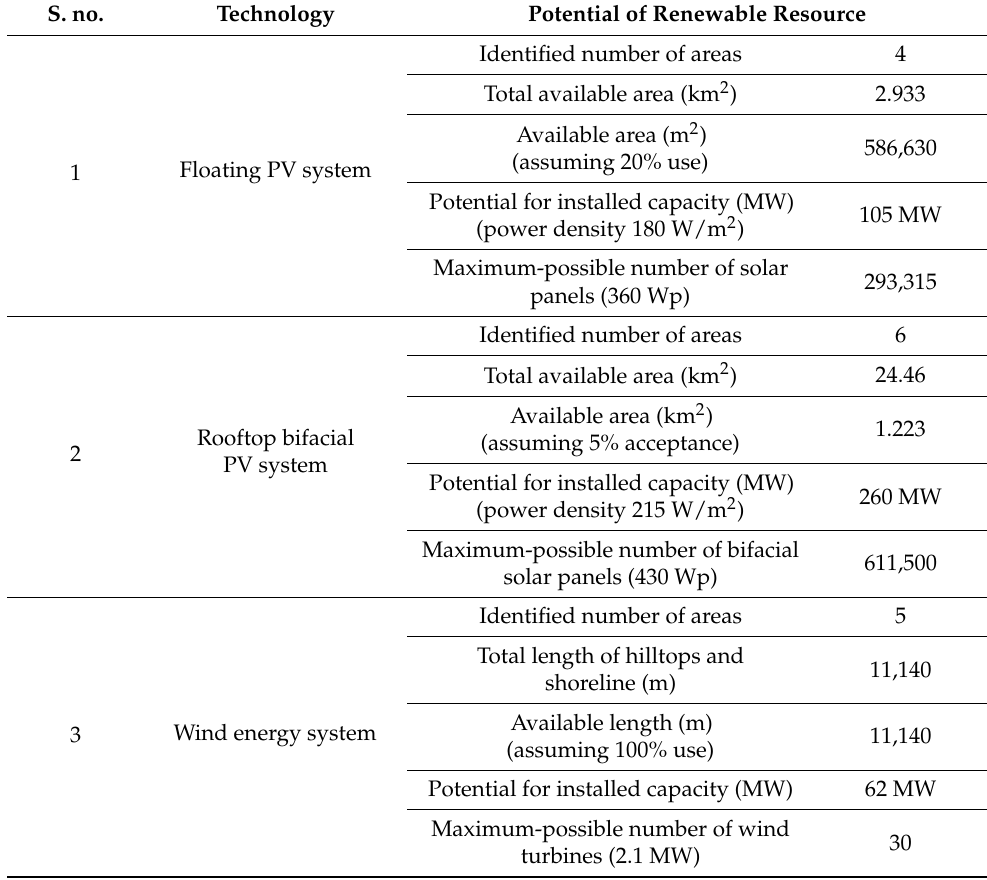
Table 2. Energy potential of various renewable energy technologies in the proposed